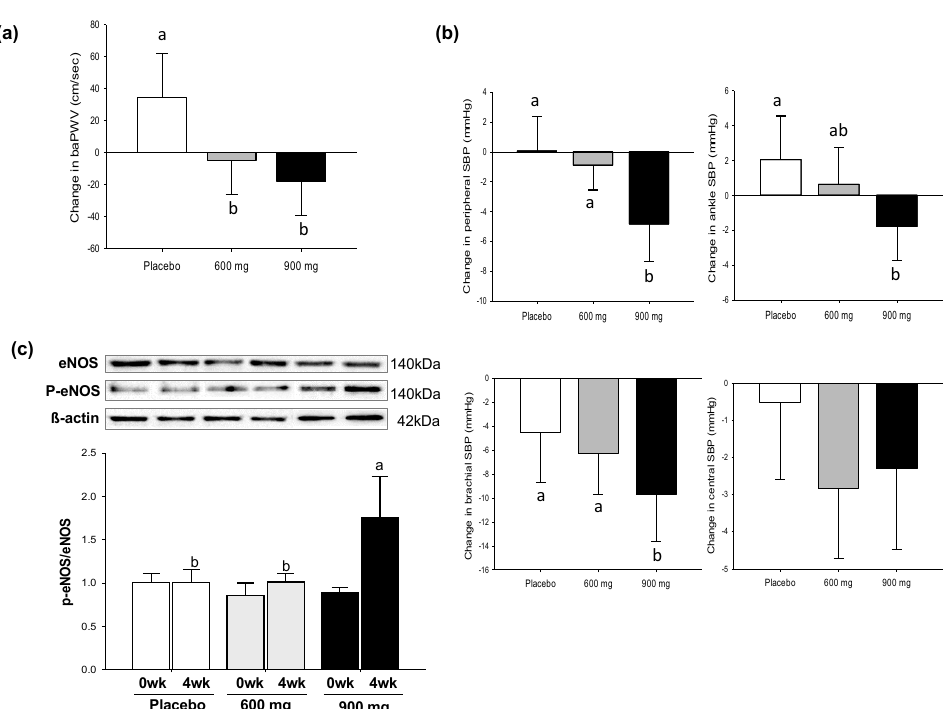
Figure 2. Changes in vasomotor responses to SD consumption for 4 weeks (wk): ( a ) baPWV; ( b ) SBP (peripheral, ankle, brachial, and central); ( c ) Western blotting of eNOS phosphorylation at Ser1177 in erythrocytes. SD, Sanghuang–Danshen; baPWV, brachial and ankle pulse wave velocity; SBP, systolic blood pressure; eNOS, endothelial nitric oxide synthase. Values are expressed as mean ± SE (standard error). The different letters indicate significant differences at p < 0.05.